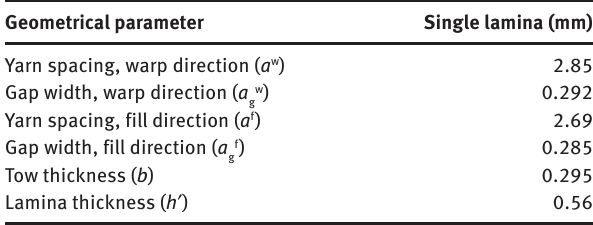
Table 1: Dimensions of the measured quantities.